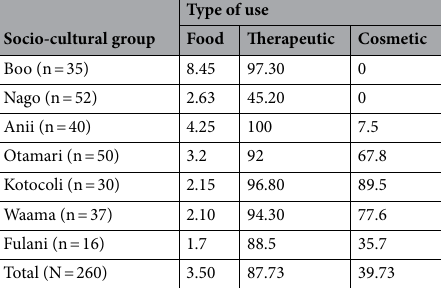
Table 1. Food, cosmetic and therapeutic uses of P. butyracea fruit pulp by different socio-cultural groups (percent of producers surveyed, N = 260). n number of respondents.